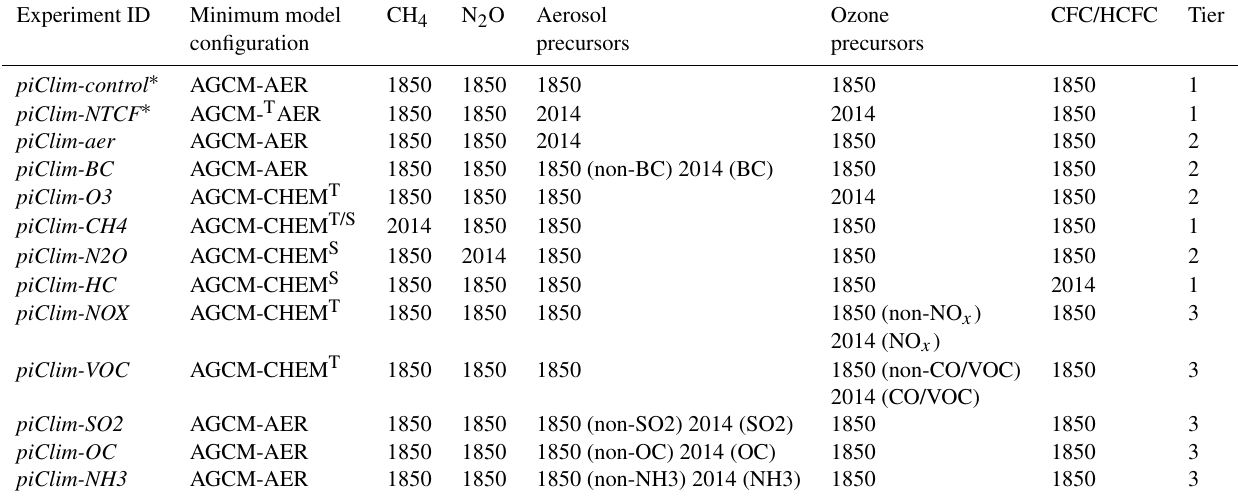
Table 6. List of fixed SST ERF simulations. These are time-slice experiments of 30 years in total, using pre-industrial climatological average SST and sea ice distributions. The “AER” suffix means that models should at least calculate tropospheric aerosols driven by emission fluxes. The “CHEM T ” or “CHEM S ” suffix means that at least tropospheric or stratospheric chemistry is required. Models should always be run with the maximum complexity available. The species columns refer to the specifications for concentrations (CH 4 , N 2 O and CFC/HCFC) or emissions (aerosol and ozone precursors). A year means the concentrations or emissions should be fixed to that